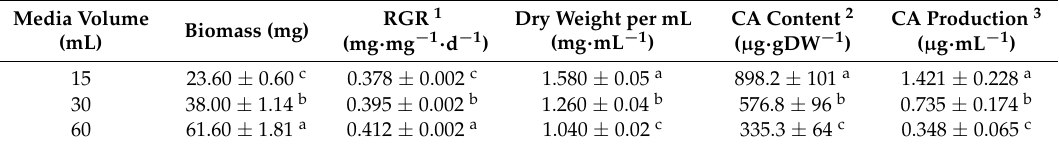
Table 2. Effects of media volume on algal growth, biomass, canthaxanthin content and production at 28